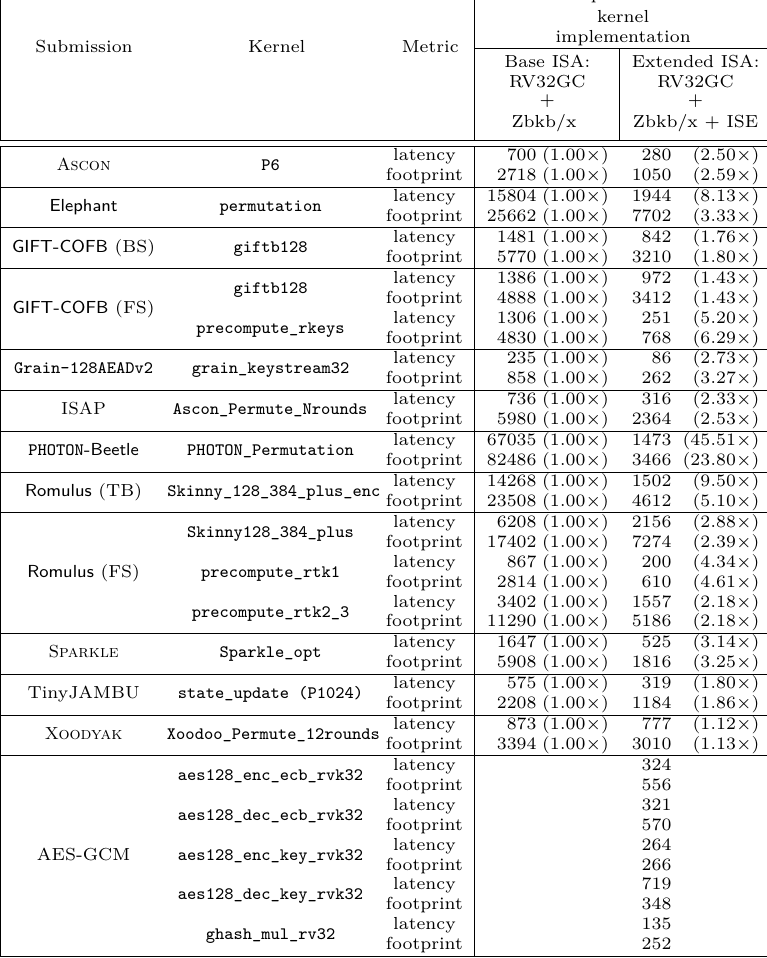
Table 3: Software-oriented evaluation, i.e., utilisation of each ISE design: latency measured in clock cycles and instruction footprint measured in bytes (plus increase/decrease factor versus base ISA in parentheses) for direct kernel